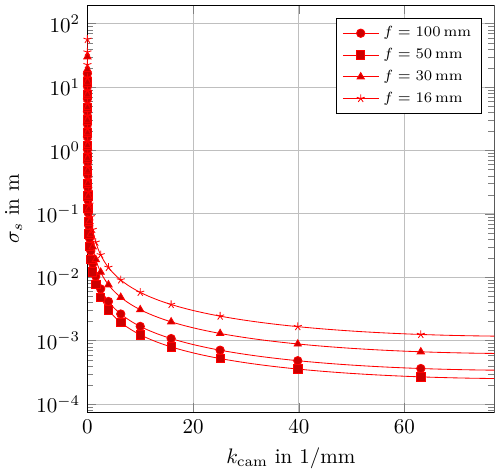
Figure 16. Measurement uncertainty of plenoptic and deflectomet- ric sensor with motion blur σ mot . The pattern is shown on the sur- face and also on the screen. Both pattern frequencies are given rel- ative to the camera sensor k cam .